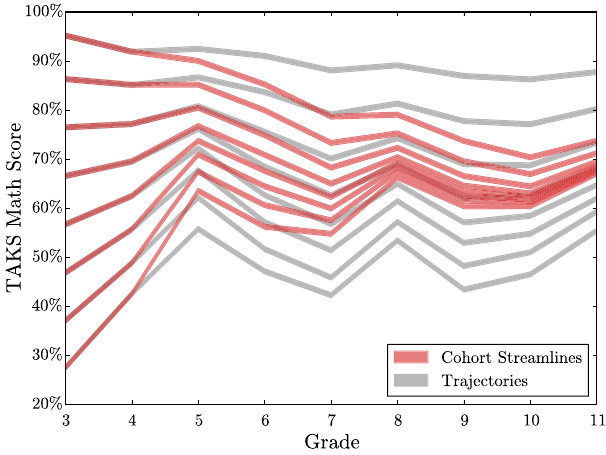
FIG. 7. Cohort streamlines and trajectories for the cohort of 2012. Both plotting schemes are representing the same cohort of students; however, the streamlines are more inclusive of students who join the cohort after 3rd grade. Due to RTM, the streamlines converge considerably compared to the trajectories. The streamlines therefore do not accurately represent the flow of student